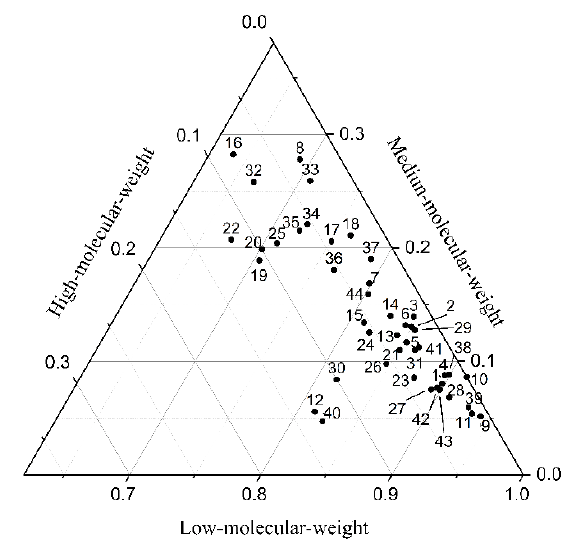
Figure 7. Compositions of PAHs in plants (See Table S6 in Supplementary Materials for plant numbers).